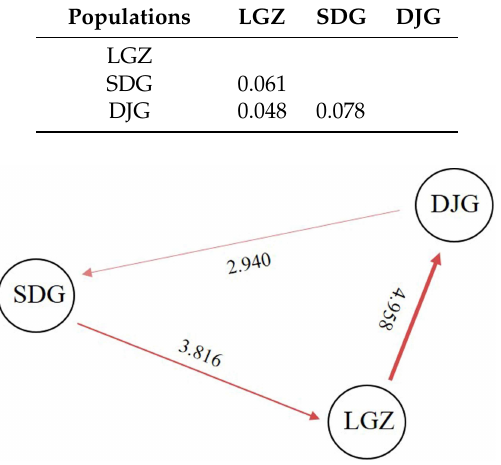
Figure 3. Estimations of gene flow among three populations by Migrate-n [43]. The width of the line and the number shown next to the arrows indicate the gene flow ( N m ) values. LGZ: Lenggouzi; SDG: Sandaogou; DJG: